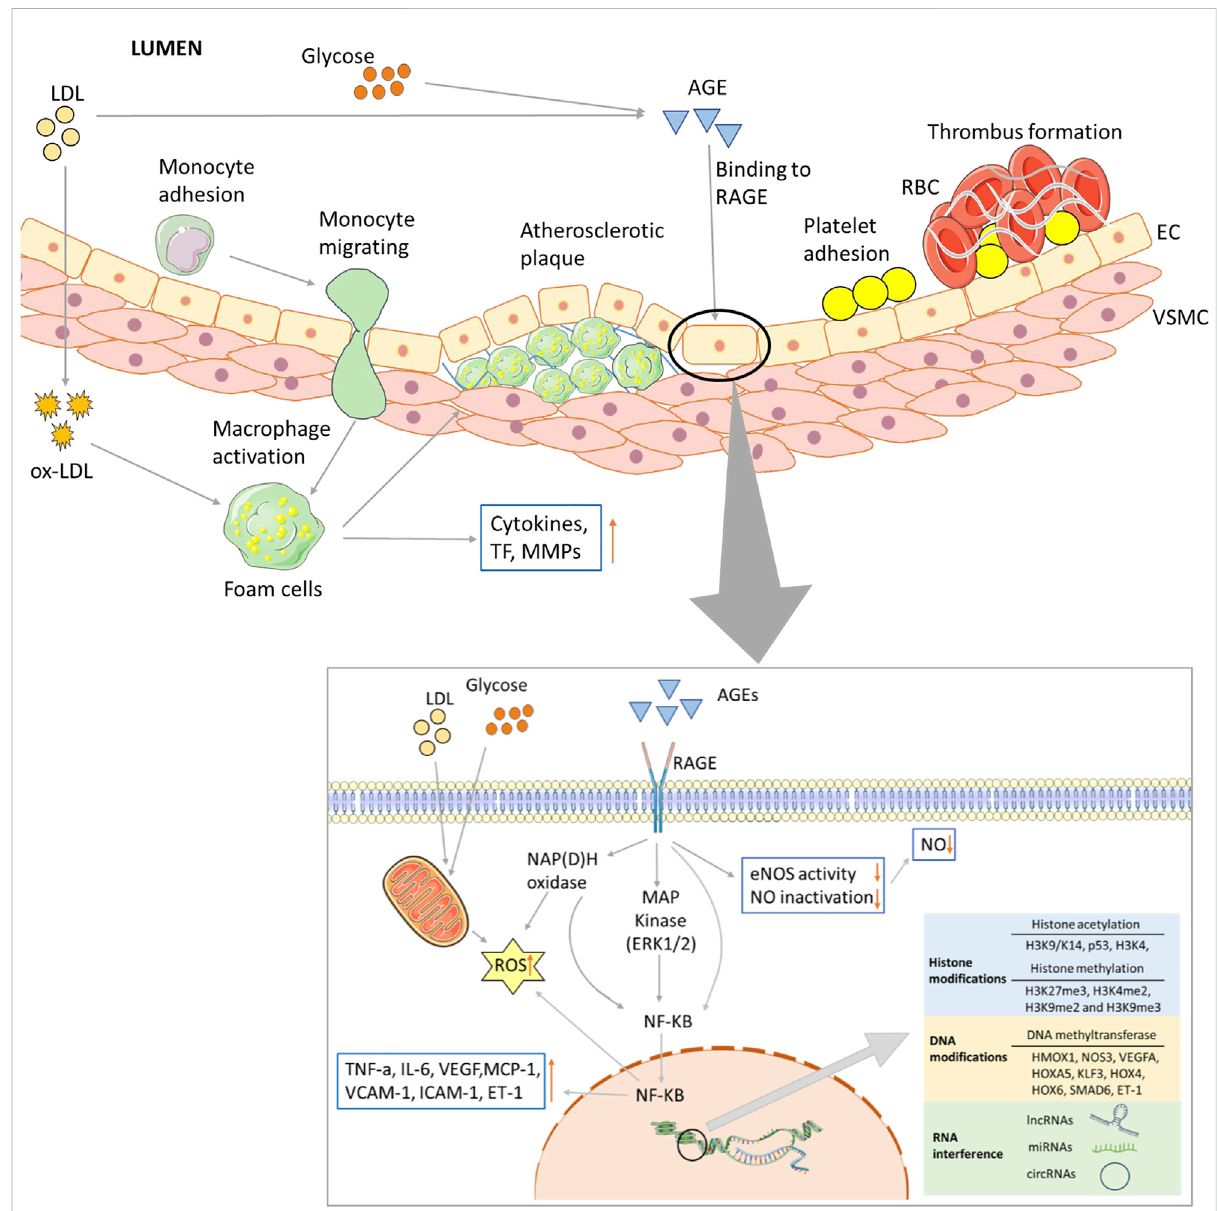
FIGURE 2 Biochemical and major pathways underlying endothelial dysregulation in vascular complications of diabetes. Long-term hyperglycemia and hyperlipidemia can cause endothelial cell dysfunction and increase the adhesion of monocytes and platelets. The former can transform into macrophages, while the latter can recruit blood cells, accumulate in blood vessels, and form thrombi. On the one hand, macrophages invade endothelial cells and engulf ox-LDL, turning into foam cells and forming arterial plaques. Macrophages release in fl ammatory and transcription factors that aggravate the in fl ammatory response. Excessive glucose and lipid levels will covalently combine to form AGEs, which can bind to their receptors; activate the MAPK and NF-KB pathways, among others; and reduce the production and utilization of NO. Abnormal glucose and lipid metabolism canalso affectmitochondrial function, produce excessive ROS,and leadto insuf fi cient energysupply.Epigenetic modi fi cations are also closely related to vascular injury in the vascular complications of T2D, including histone and DNA modi fi cations, and ncRNA